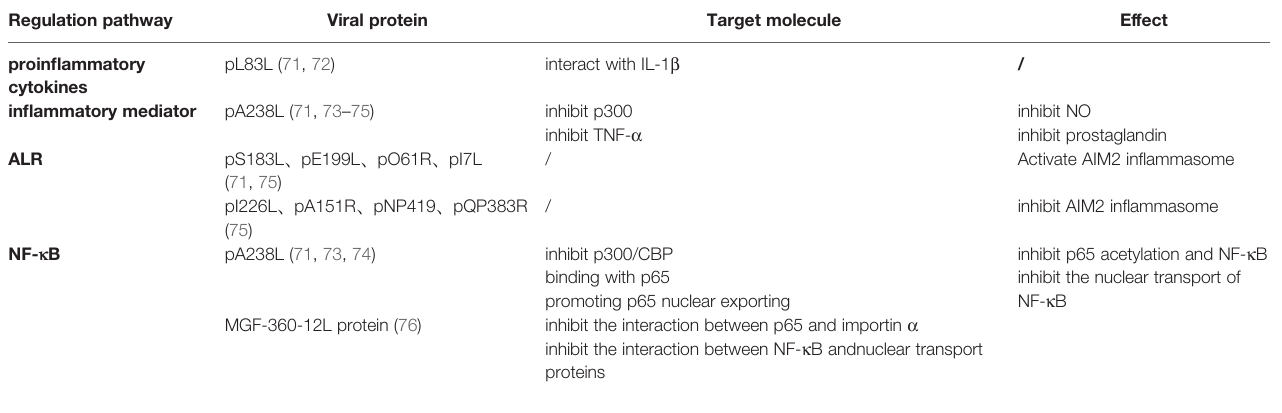
TABLE 1 | African swine fever virus (ASFV) regulates in fl ammation through regulating proin fl ammatory cytokines, in fl ammatory mediators, ALR and NF- k B pathway. Regulation pathway Viral